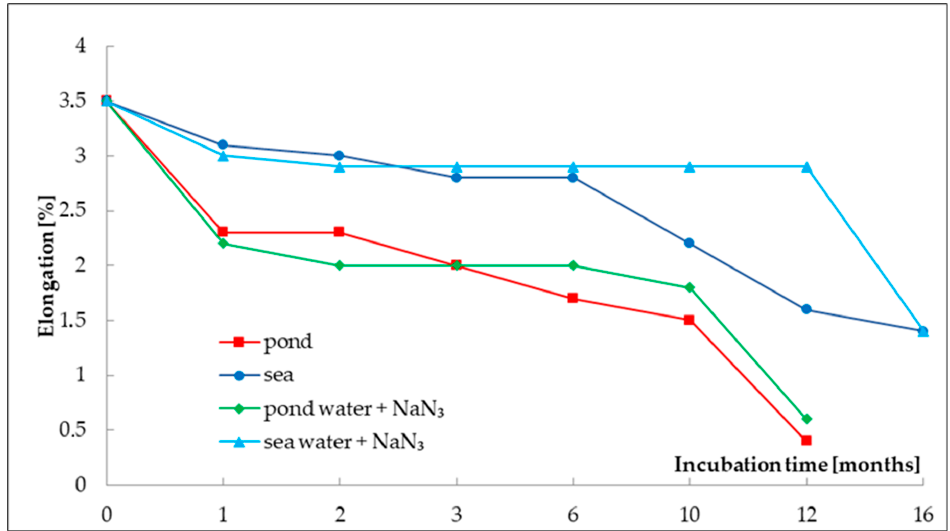
Figure 7. Elongation [%] of the PLA samples after incubation in different aqueous environments. Source: Own